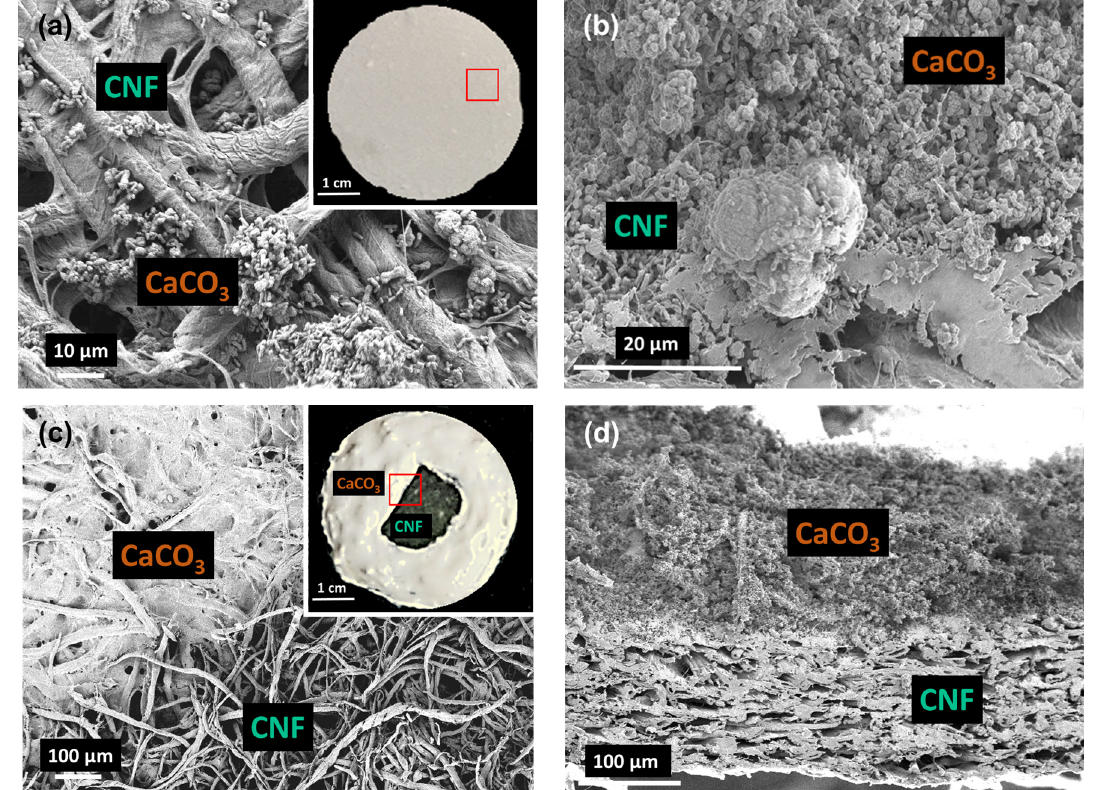
Figure 5. Morphological structure of the surface of ( a ) the CNF mixture with CaCO 3 , CaCO 3 –CNF–M (inset shows a 3D printed CaCO 3 –CNF–M), ( b ) the cross-sectional film of CaCO 3 –CNF–M, ( c ) CNF laminated with CaCO 3 , (inset shows a 3D printed CaCO 3 –CNF–L) and ( d ) the cross-sectional film of CaCO 3 –CNF–L.